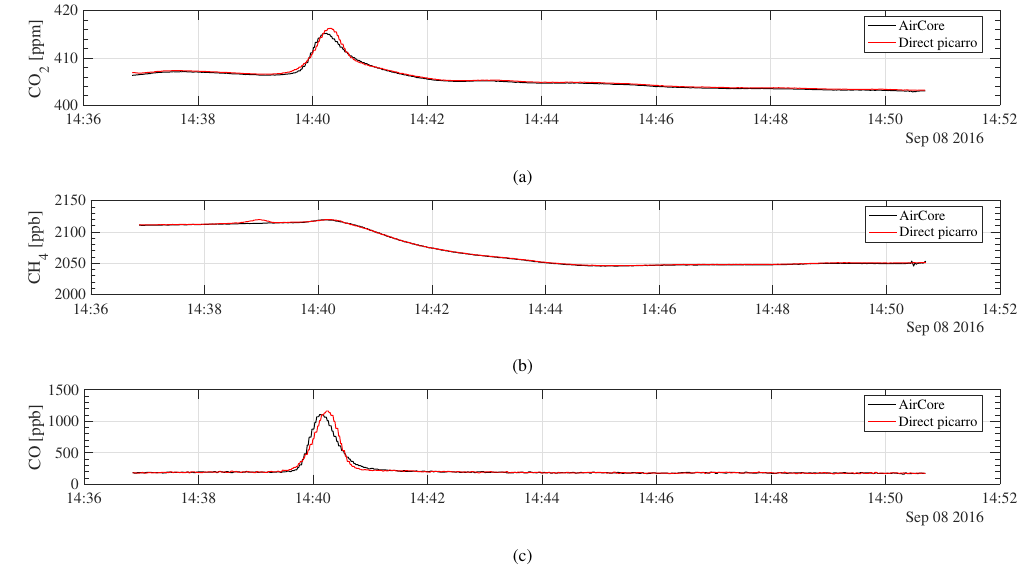
Figure 3. Measured mole fractions of CO 2 , CH 4 , and CO for both the direct roof air measurement and the AirCore sampled